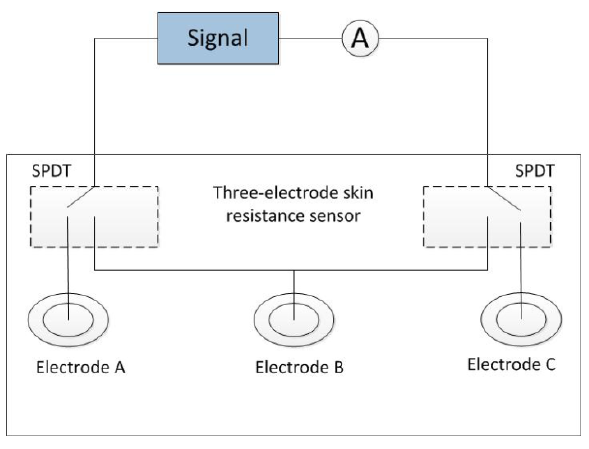
Figure 2. Skin resistance measuring system.